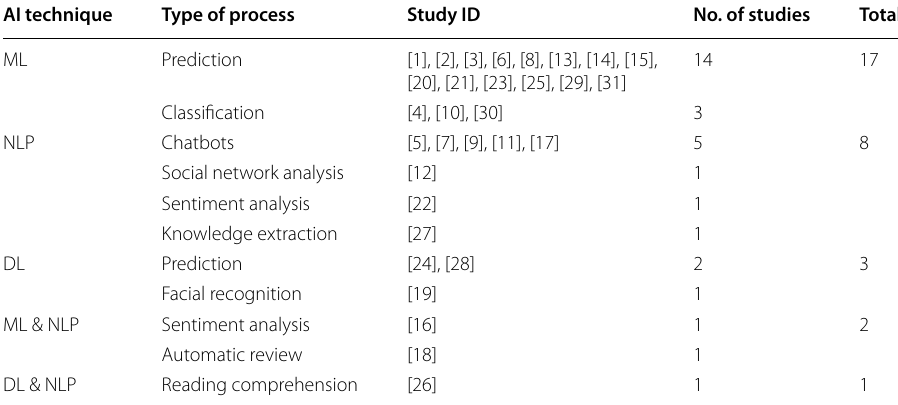
DL deep learning, ML machine learning, NLP natural learning processing